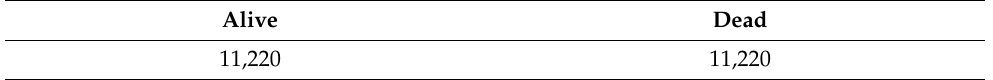
Table 3. Number of synthetic sequences of each class (alive/dead) generated with the